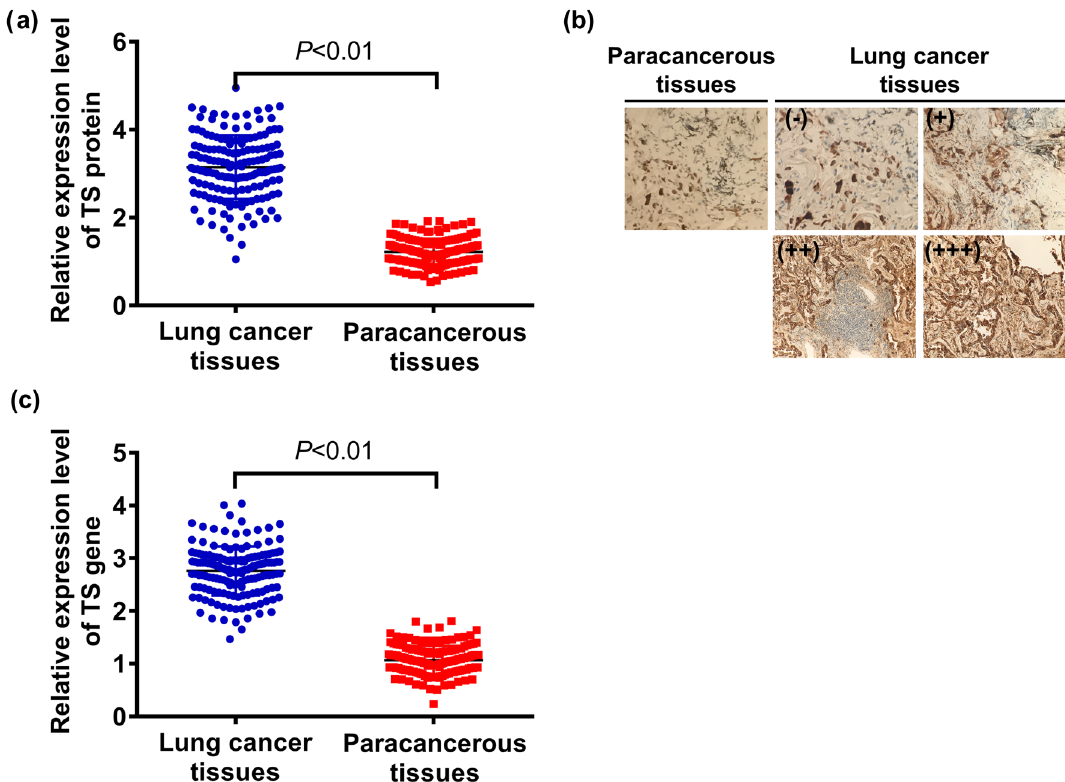
Figure 1: The expression of TS in NSCLC patients. ( a ) The expression of TS protein was detected by Western blot analysis. ( b ) The expression of TS protein was detected by immunohistochemical staining. ( c ) The expression of TS gene was detected by qRT - PCR.